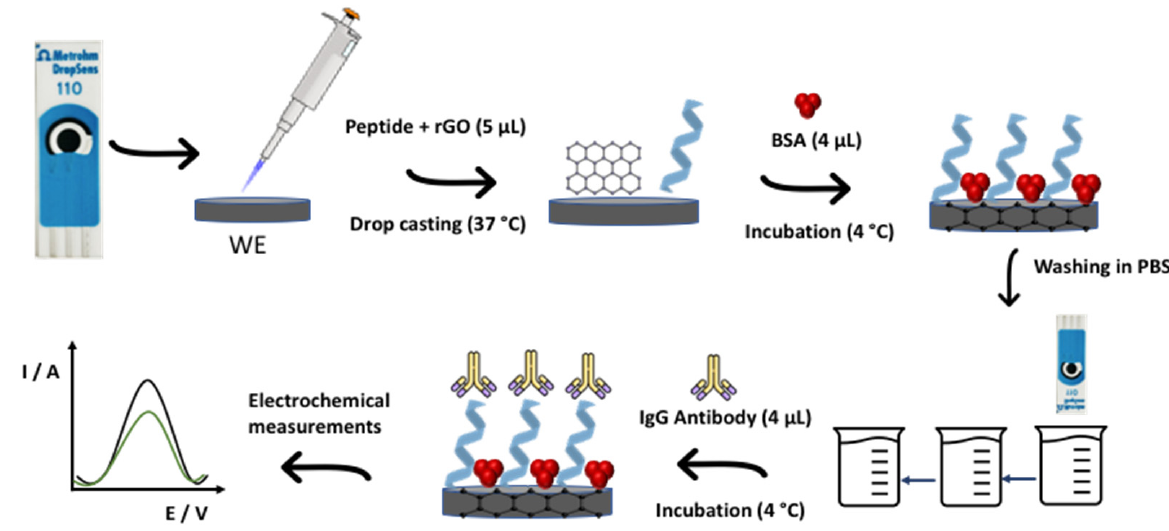
Figure 1. Schematic illustration of immunosensor step-by-step construction.